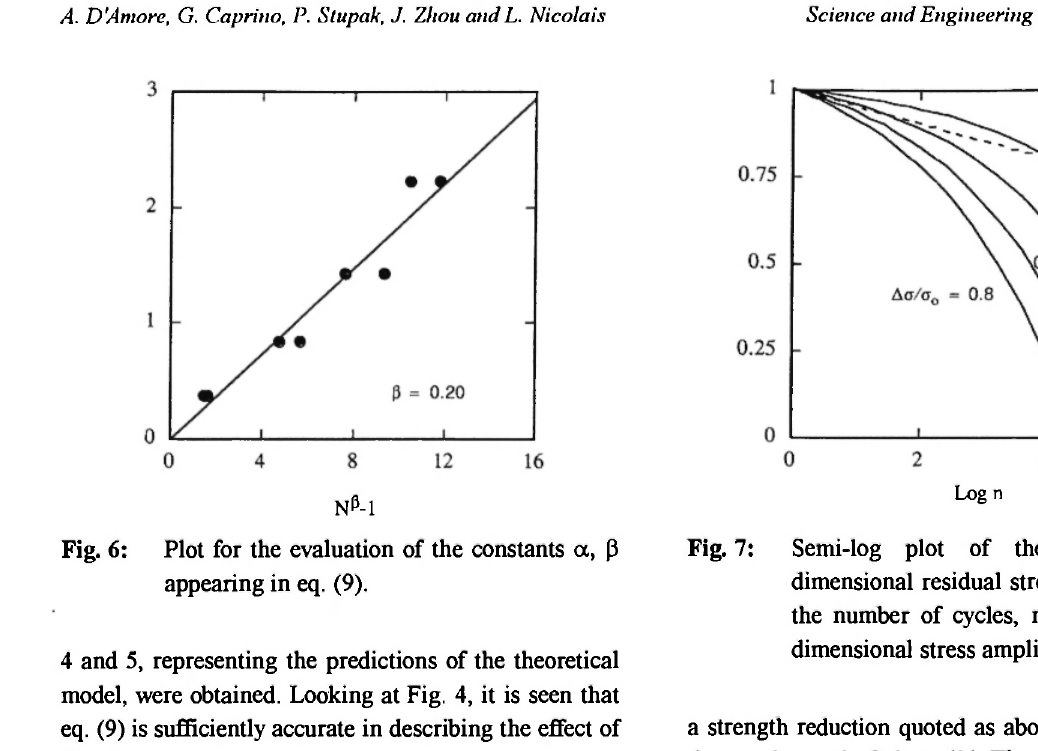
Log η Fig. 7: Semi-log plot of the theoretical non- dimensional residual strength, σ„/σ 0 , against the number of cycles, n, for different non- dimensional stress amplitudes, Δσ/σ 0